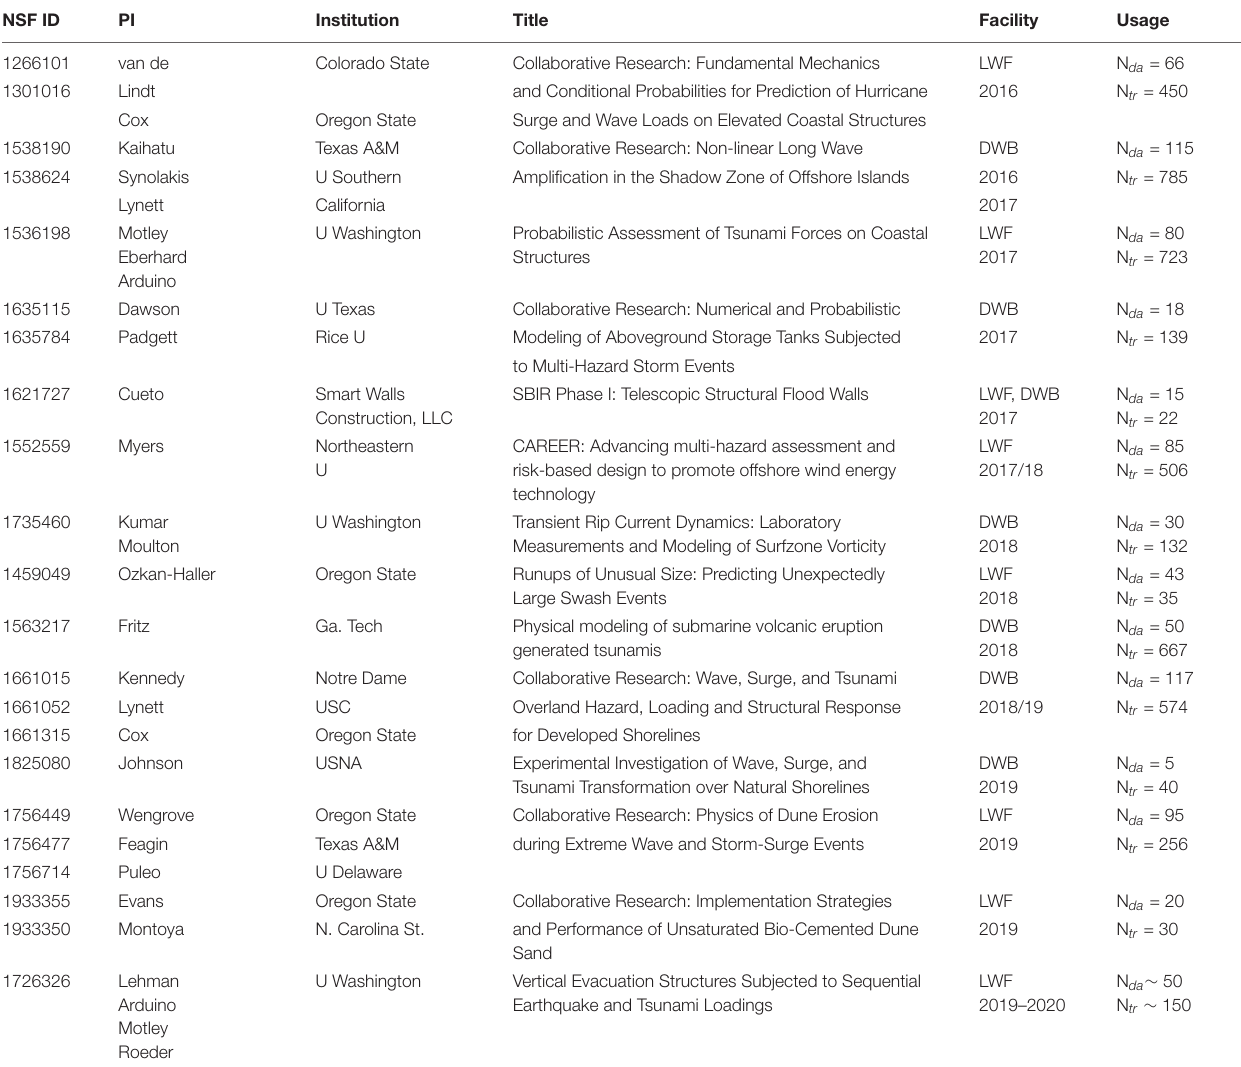
TABLE 1 | Projects conducted in the NHERI HWRL